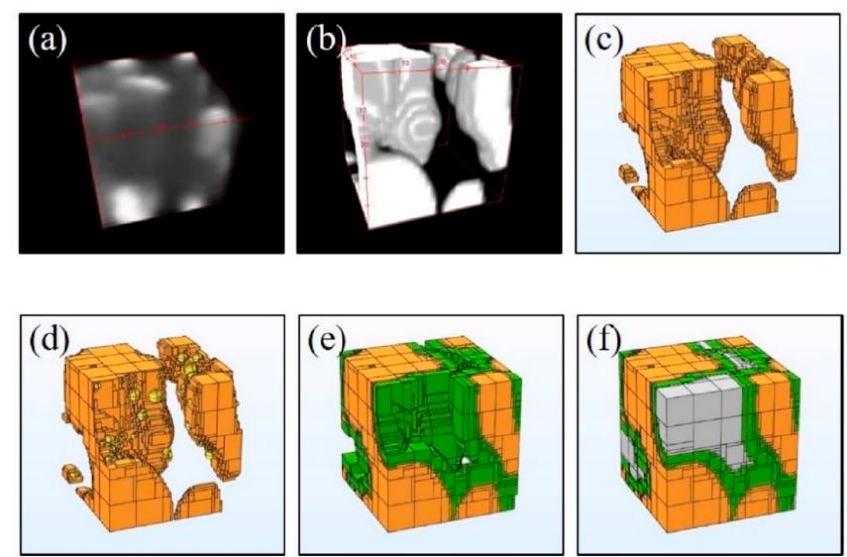
Figure 9. Numerical domain of a multi-physical model for CL [55]; ( a ) RAW FIB-SEM stack section portion of [100 × 100 × 100 nm]; ( b ) corresponding to the segmented stack section; ( c ) corresponding reconstructed carbon phase; ( d ) carbon phase with platinum particles distributed on the surface; ( e ) addition of an ionomer layer on the Pt/C aggregate; ( f ) addition of pore phase. (Legend grey: pore phase; green: ionomer stage; orange: carbon phase; yellow: platinum phase).